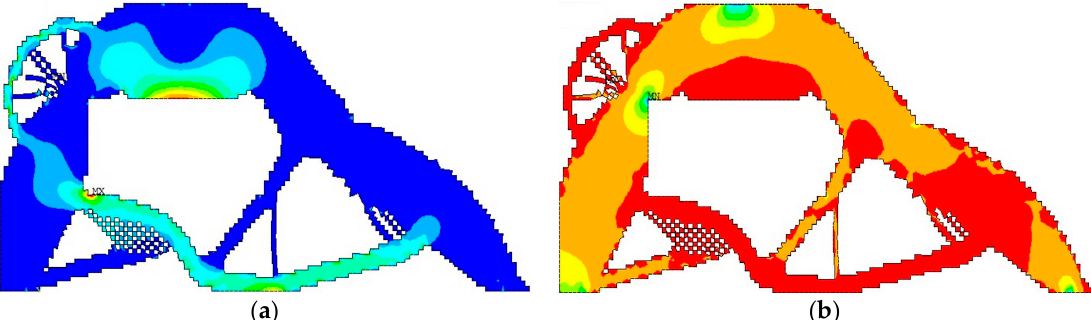
Figure 4. Optimal topology of the irregular concrete deep beams: ( a ) Group A beam; ( b ) Group B beam.